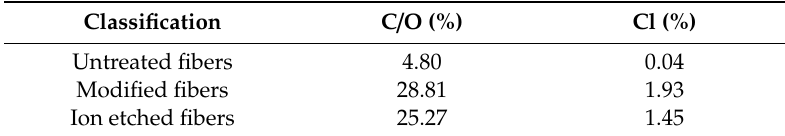
Table 3. C/O atomic ratio and element composition of the Cl of the untreated aramid fibers and sample 2 in Table 1.